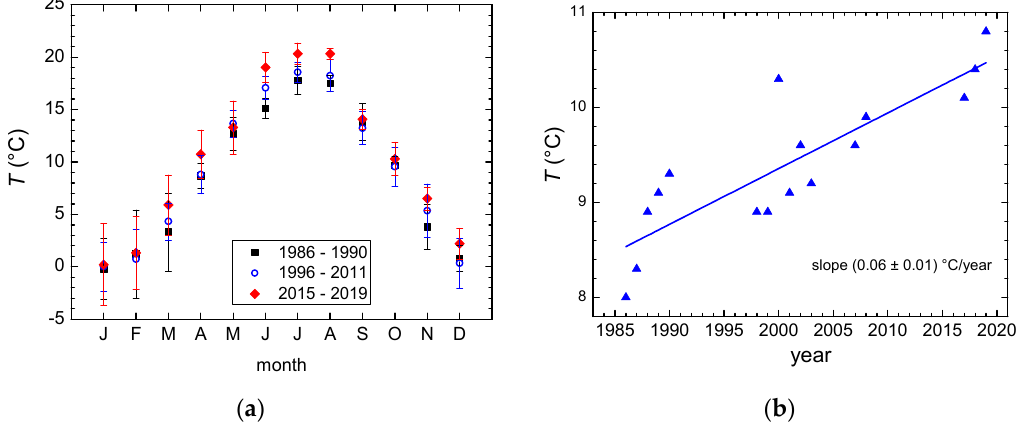
Table 2. Mean annual temperature and annual precipitation amount in the three periods with available meteorological data.